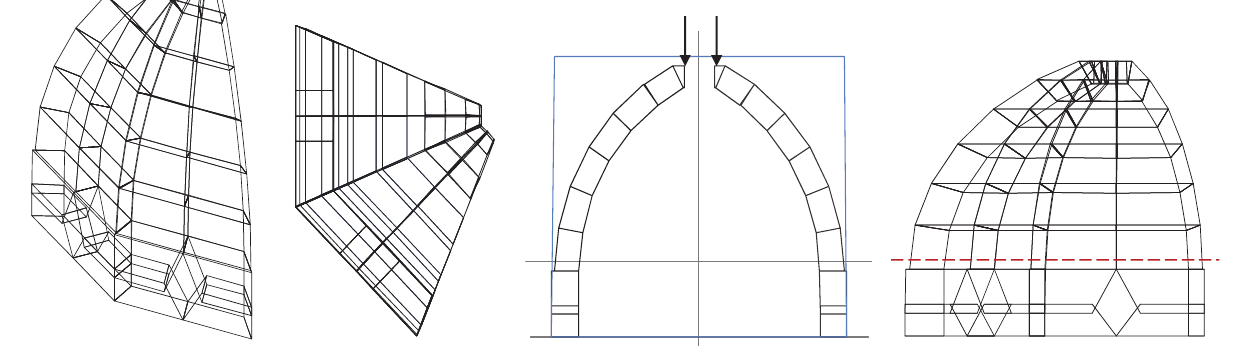
Figure 19: Collapse mechanism of S. Maria del Fiore dome